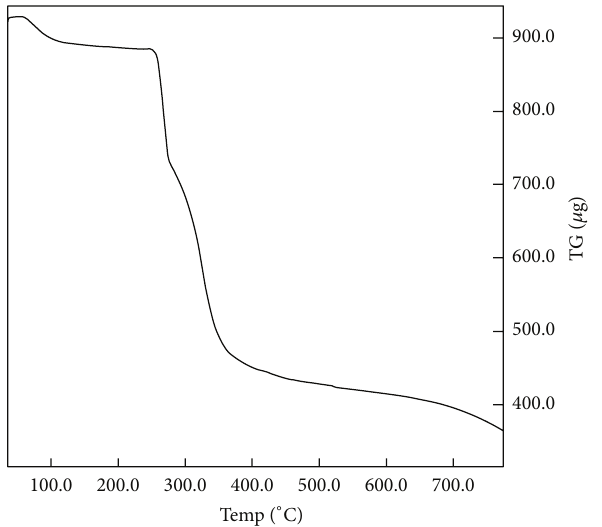
Figure 3: Thermogravimetry curve of { [Bi(NNO) 2 (NO 3 )] ⋅ 1.5H 2 O } ( 1 ).